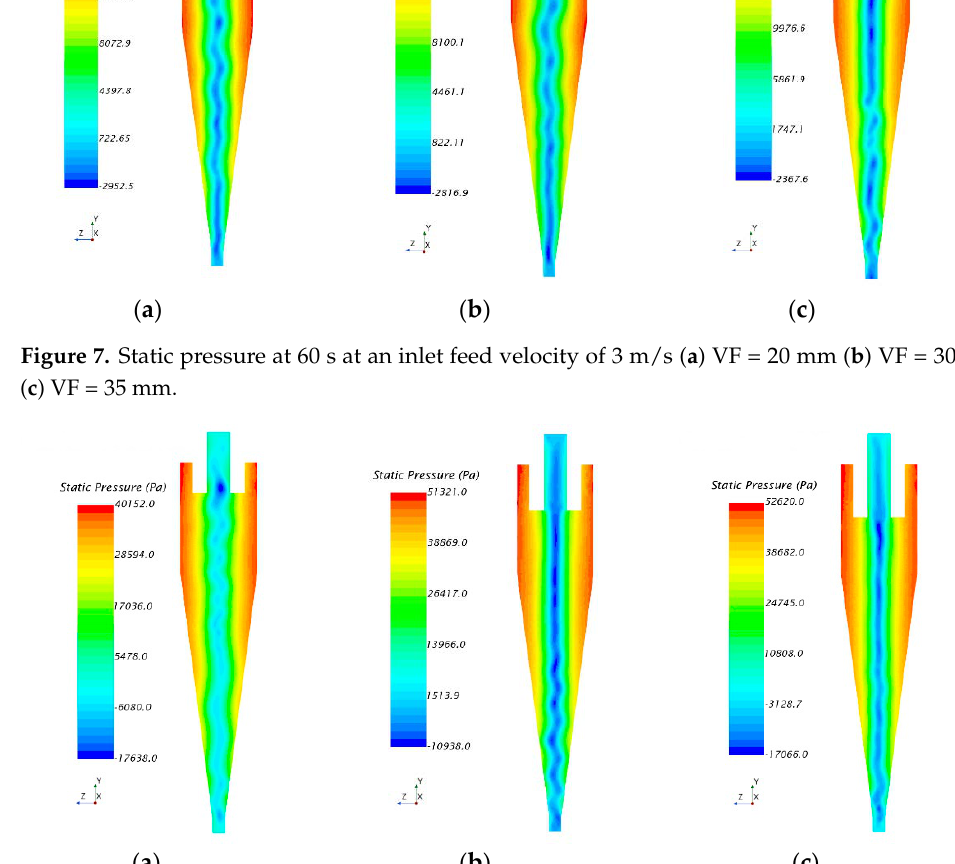
Figure 8. Static pressure at 60 s at an inlet feed velocity of 5 m/s ( a ) VF = 20 mm ( b ) VF= 30 mm ( c ) VF = 35 mm.